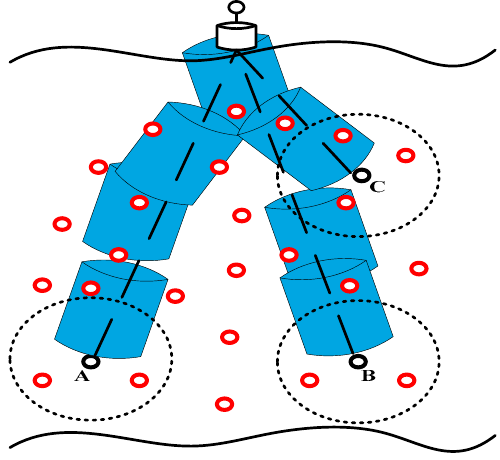
Figure 3. Virtual pipelines in HH ‐ VBF.